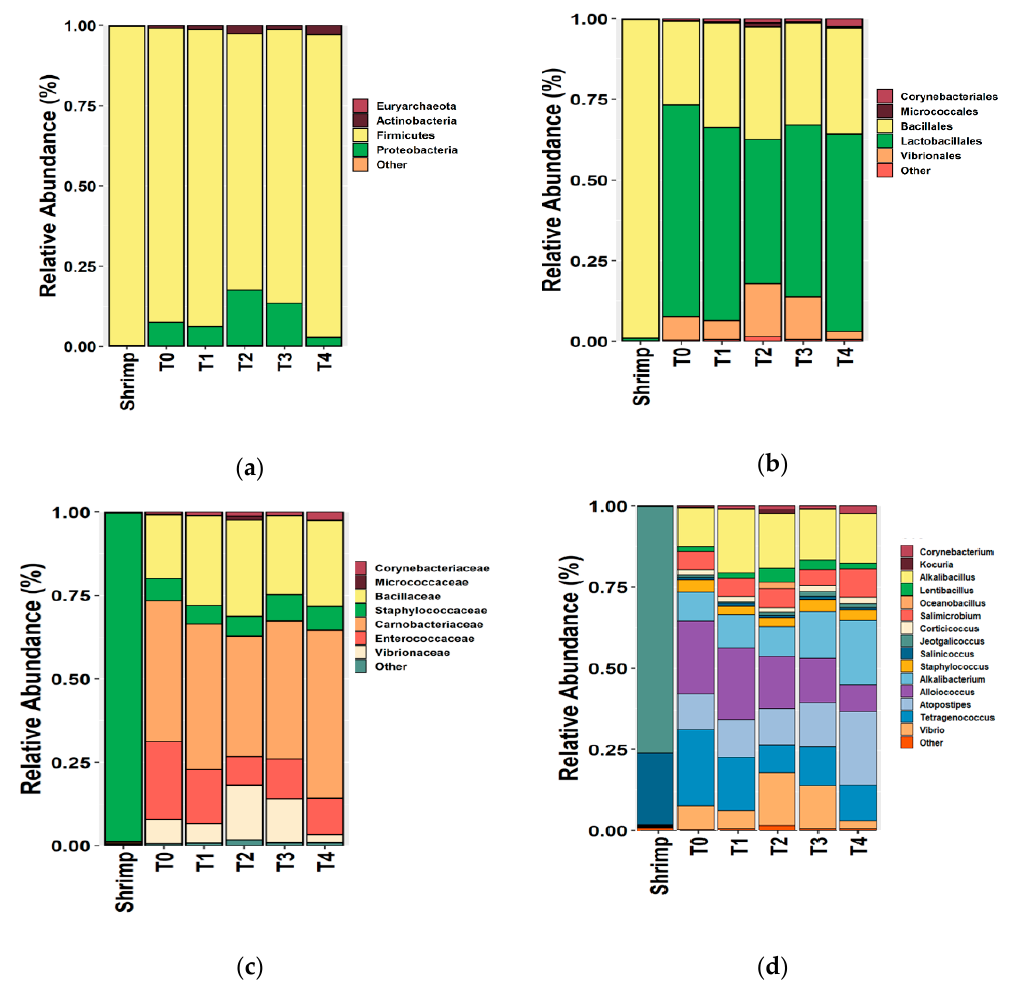
Figure 1. The relative abundance of bacterial OTUs from shrimp material and low-salt shrimp paste at the phylum ( a ), order ( b ), family ( c ), and genus ( d ) levels, revealed by Illumina sequencing, using the V3–V4 variable region of 16S rRNA, and analyzed by QIIME. Only dominant orders, families, and genus were selected (relative abundance more than 1%). T0 = 0 days of fermentation, T1 = 7 days of fermentation, T2 = 14 days of fermentation, T3 = 21 days of fermentation, T4 = 28 days of fermentation.